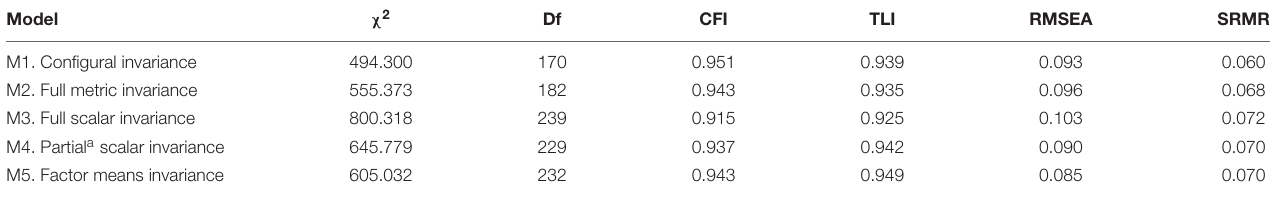
TABLE 3 | Model fit statistics of the three factorial structures for each culture.